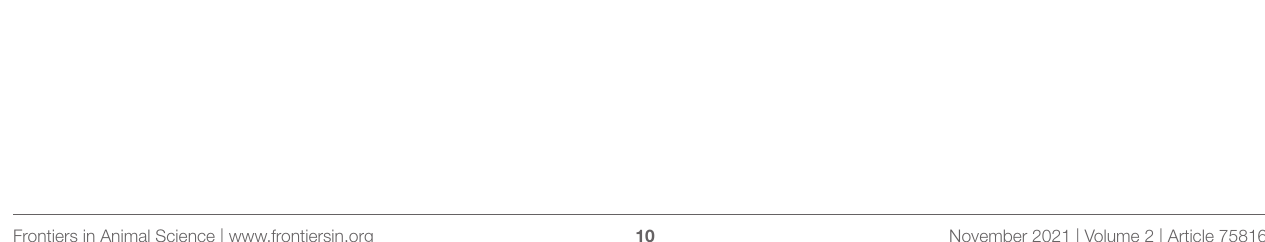
Frontiers in Animal Science |